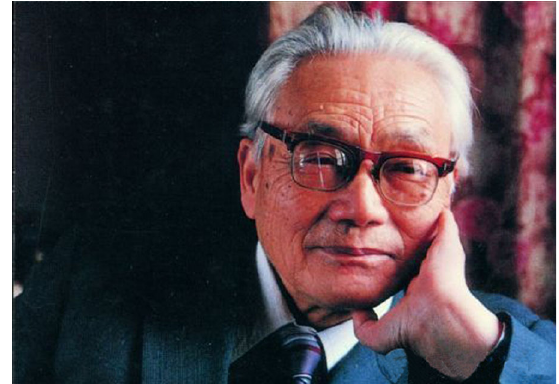
Figure 1. Prof. Chen Hua-Kui (1914 – 2002).